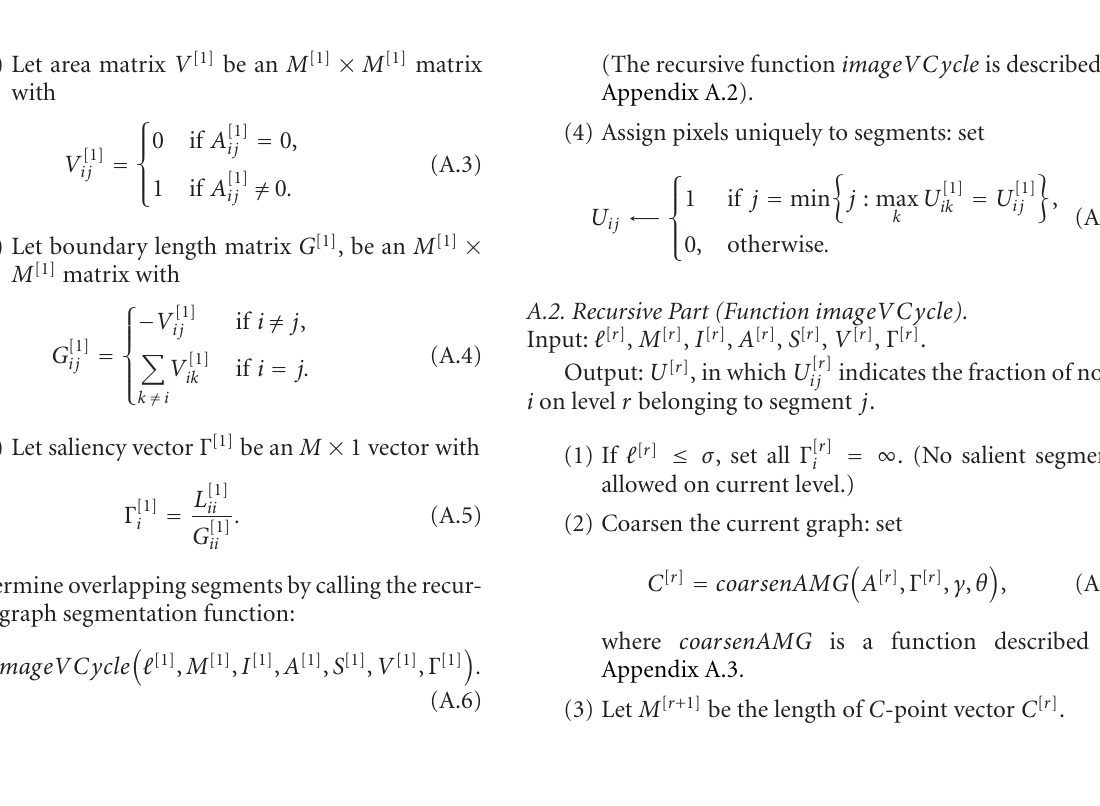
Figure 22: 3 segments found with parameters ( n , α , (cid:7) α , β , θ , γ , d 1 , σ , ρ ) = (60,11,2,300,0 . 015,0 . 05,0 .